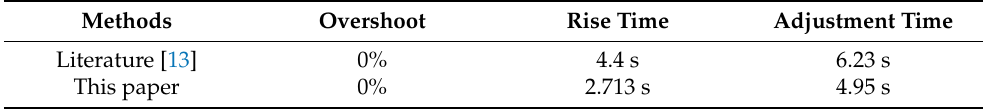
Figure 3. Simulation diagram of improved sparrow search algorithm. Table 2. Comparison of control